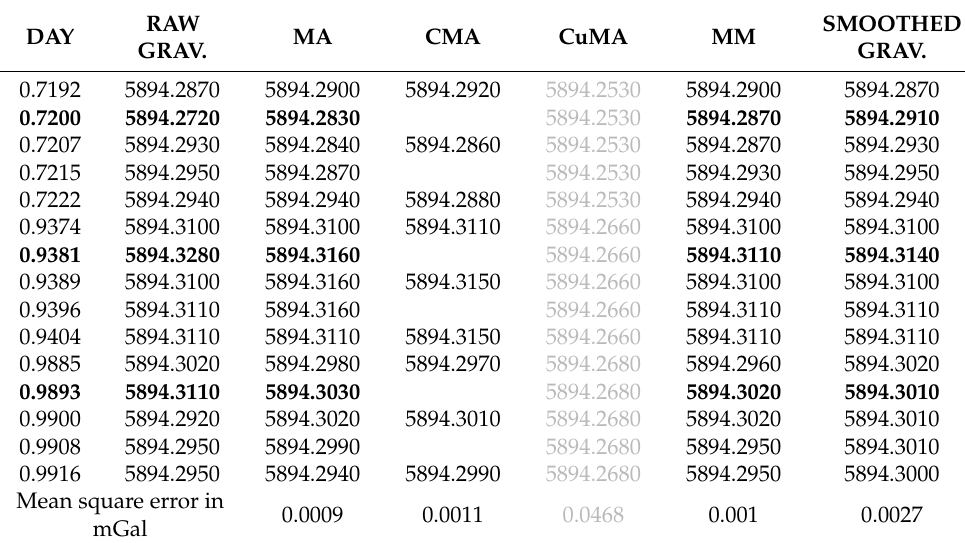
Table 1. A demonstration of the sensitivity of the particular smoothing